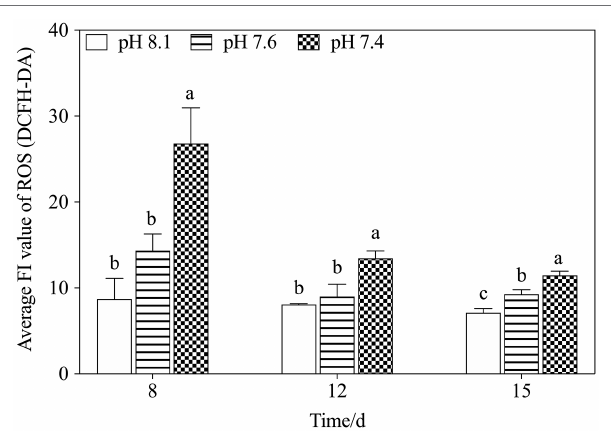
FIGURE 8 | Changes in ROS levels in K. mikimotoi under exposure to different pH levels. Data are presented as means ± SD. Different lowercase letters indicate significant differences between the treatment and the control at each time point ( p <